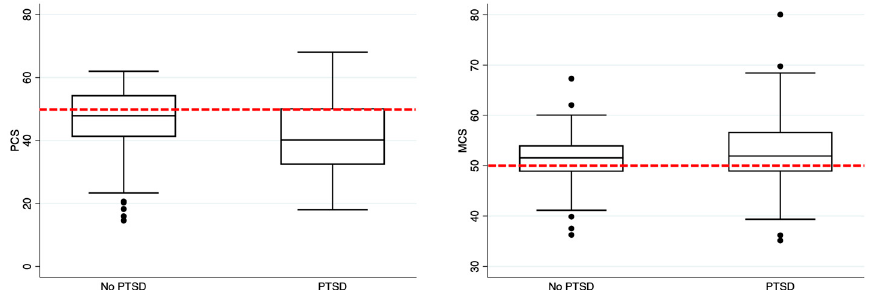
Figure 3. HRQoL comparison between patients without and with PTSD. In the left part of the figure, it represents the comparison between no PTSD versus PTSD patients regarding the PCS, while in the right part of the figure, the MCS comparison is shown.